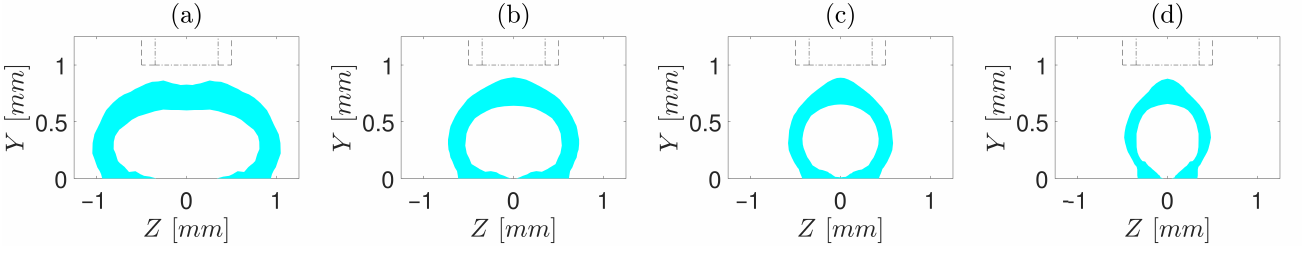
Figure 10. Cross-sections of the core–shell strand for t / D = 1, d / D = 0.7 and different V / U of ( a ) 0.5, ( b ) 0.75, ( c ) 1, and ( d ) 1.25. Core diameter and orifice are marked by “- -” and “-·”,